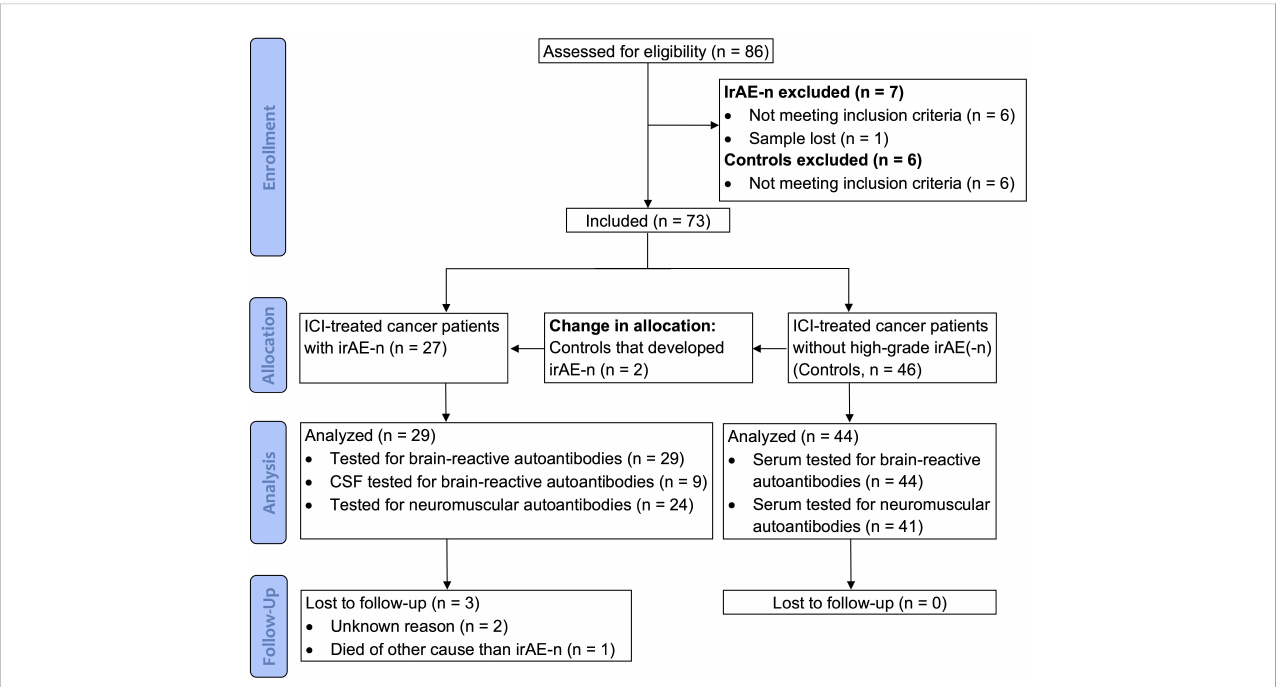
FIGURE 1 CONSORT diagram. Between September 2017 and January 2022, a total of 86 cancer patients were enrolled for the study. After application of inclusion and exclusion criteria, 73 patients were included. As two patients that were originally allocated to the control cohort developed irAE-n, a total of 29 irAE- n patients and 44 cancer control patients were analyzed. CSF, cerebrospinal fl uid; ICI, immune checkpoint inhibitor; irAEs, immune related adverse events; irAE-n, neurological immune related adverse